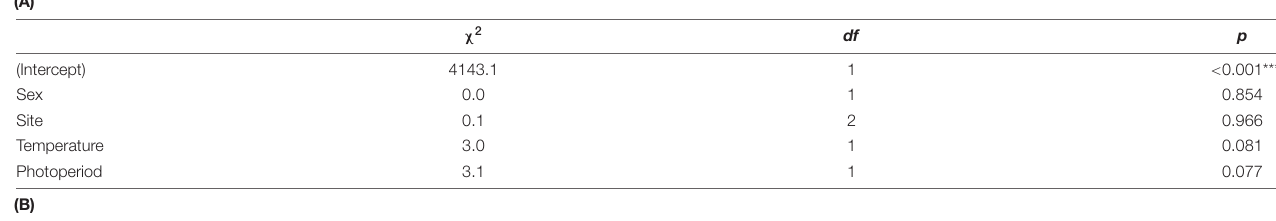
TABLE 2 | Wald 3 ANOVA of our linear mixed effects model of (A) preferred body temperature, and (B) CTmin and CTmax ( ◦ C) as a function of temperature variance, photoperiod, sex, site, and interactions.